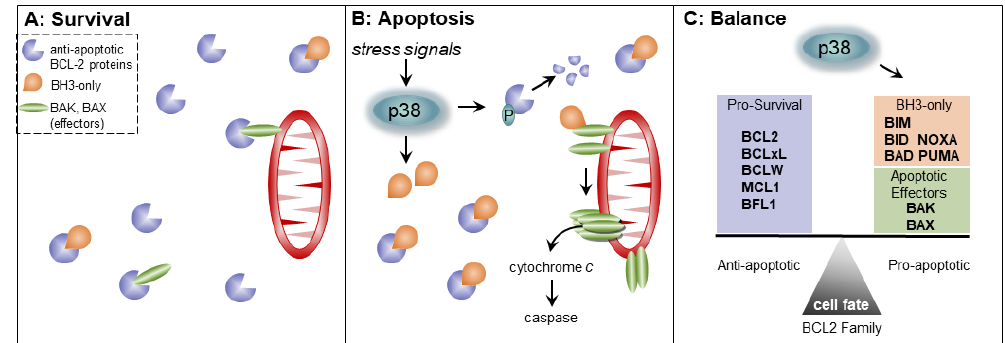
Figure 3. p38 stress signaling tips the balance of BCL2 family interactions towards cell death. ( A ) Pro-survival proteins (BCL2, MCL1, etc.) mediate survival by binding and preventing apoptotic effectors (BAK and BAX) from pores in the outer mitochondrial membrane. The anti-apoptotic proteins bind and inhibit both the pro-apoptotic BH3-only proteins and apoptotic effectors. ( B ) During cell stress, active p38 upregulates expression of BH3-only proteins (BIM, BID, etc.). These BH3-only proteins can either directly activate BAK or BAX or inhibit anti-apoptotic proteins. Active p38 can phosphorylate and induce degradation of some anti-apoptotic proteins. These stress-initiated events lead to the homo-oligomerization of the BCL2 effectors causing membrane permeabilization, cytochrome c release, caspase activation, and cell death. ( C ) Stress-activated p38 signaling shifts the balance of the BCL2 family towards apoptosis. Table 1. List of key proteins discussed in the text (relevant references in the text).